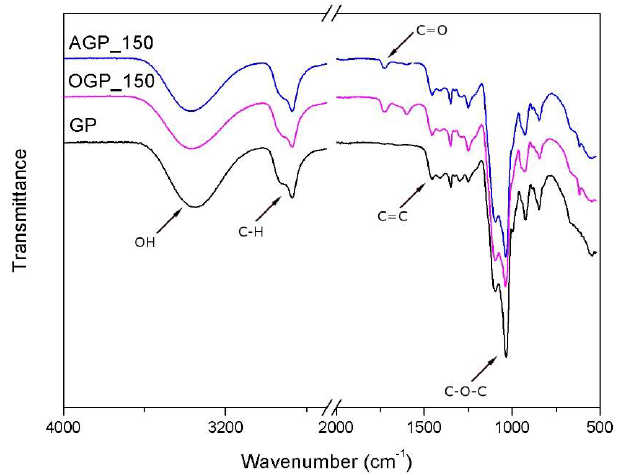
Figure 5. FTIR spectra of bio-polyols.